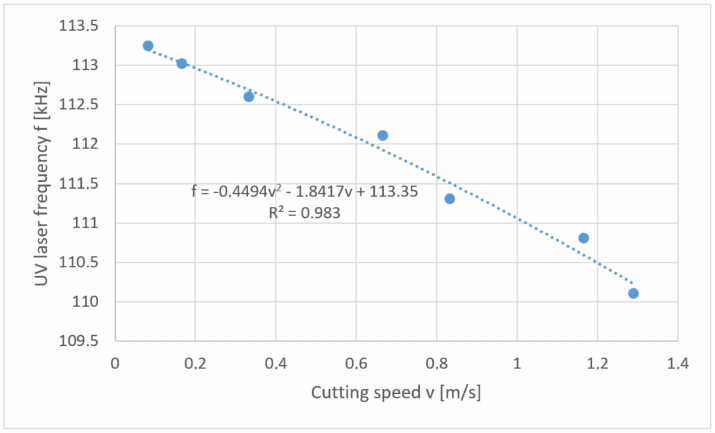
Figure 12. Reverse task solution for cutting foil with thickness t = 50 µ m.